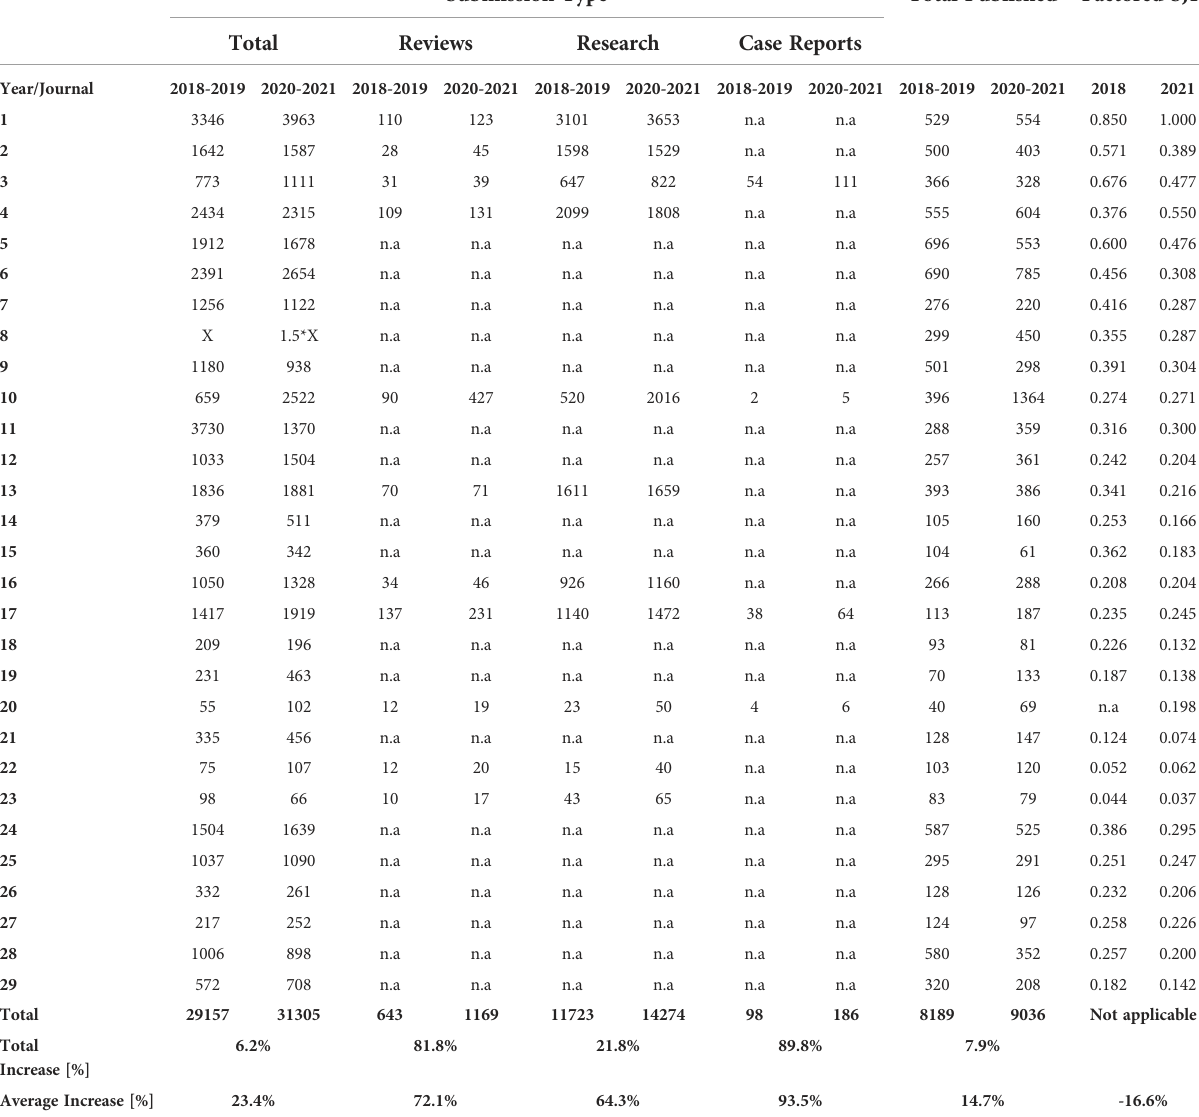
TABLE 1 Summary of submission and publication data of every contributing journal by 2 year time